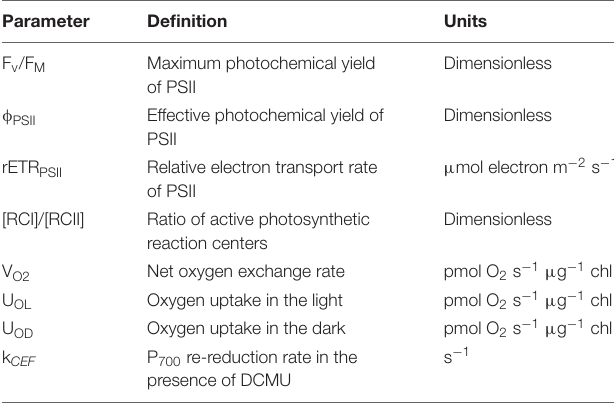
TABLE 2 | Table of terms, definitions, and units for photosynthetic traits measured in this